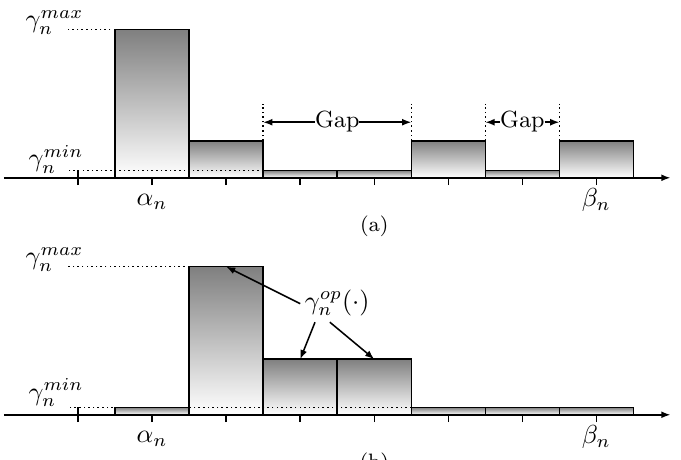
Figure 1. Examples of ( a ) nonatomic and ( b ) atomic scheduling of appliance energy consumption, ) are the minimum, the maximum, and the operating energy levels of where γ min n , γ max n , and γ op n ( · an appliance for a time slot.